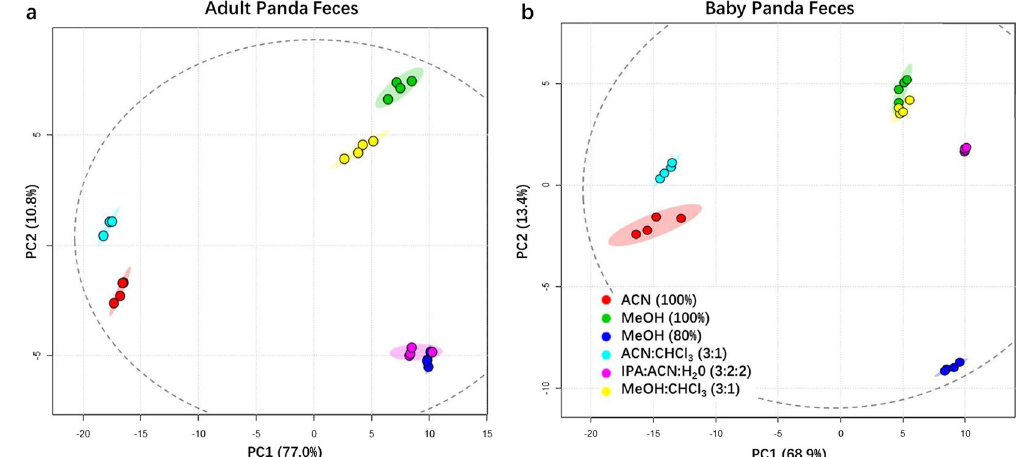
Figure 3. Principal component analysis (PCA) of the adult ( a ) and baby ( b ) giant panda fecal metabolomes, extracted using six different solvents. Each color represents an extraction method. Red colored dots represent ACN (100%); green colored dots represent MeOH (100%); blue colored dots represent MeOH (80%); cyan colored dots represent ACN:CHCl 3 (3:1); Purple dots represent IPA:ACN:H 2 O (3:2:2); and yellow dots represent MeOH:CHCl